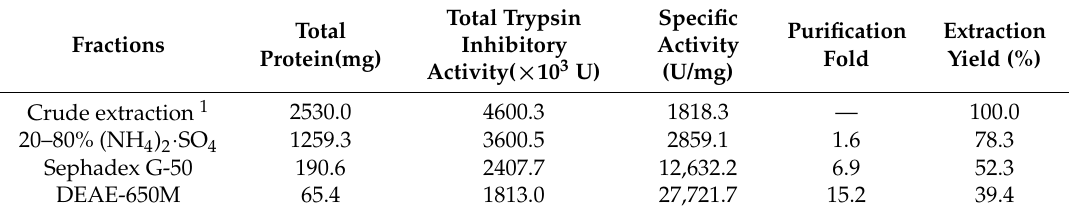
Figure 2. SDS-PAGE of PHTI. ( a ) Lanes: M, molecular mass marker; 1 and 2, PHTI with and without addition of beta-mercaptoethanol stained by Coomassie brilliant blue. ( b ) PHTI stained by periodic acid-schiff (PAS) reagent. Table 1. Summary of the purification process for PHTI and its trypsin inhibitory activity.